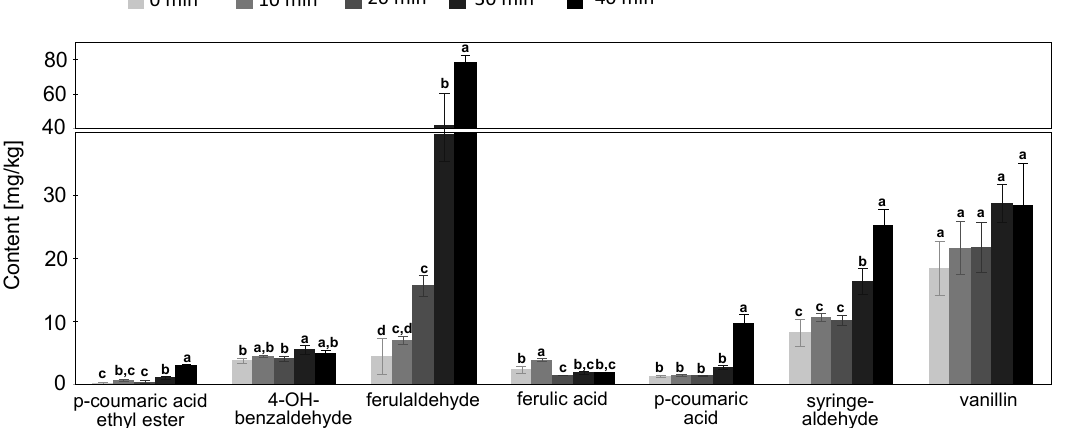
Figure 4. Changes of phenolic compounds composition during roasting process shown as concentration in mg/kg (mean ± SD, analytical replicate = 3). Values with different letters for each compound are significantly different in comparison to the other time points by applying Tukey–Kramer HSD test ( p < 0.05).